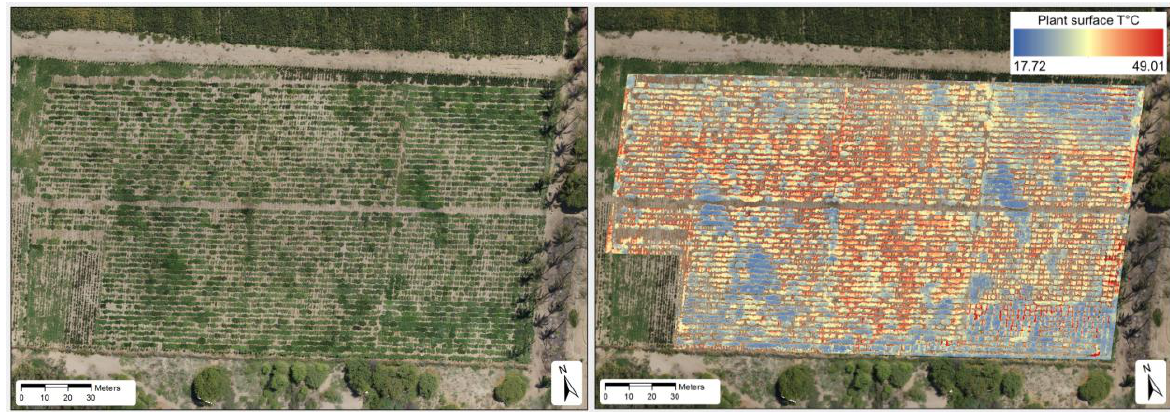
Figure 10: Fresh yield (t/ha) at 70 days after planting new clones (black triangles) of a virus resistant potato population growing in the lowland tropics, and three local varieties (Unica, Reiche, and Revolucion; red triangles comm.) with black outlines) (source: M. Bonierbale, pers. comm.)